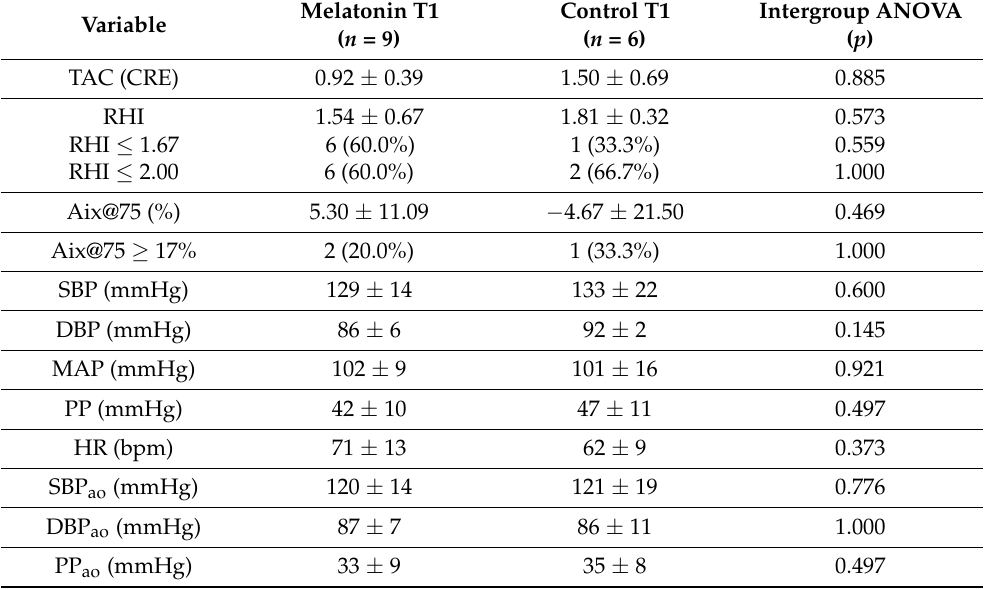
Table 3. Final evaluation (T1) of plasma parameters' total antioxidant capacity (TAC), endothelial function with non-invasive method (EndoPAT), and peripheral plethysmography for the evaluation of indices of arterial stiffness (SphygmoCor) in both melatonin and control group. * Standard deviation not reported; only one value analysed. Data are expressed as mean ± standard deviation